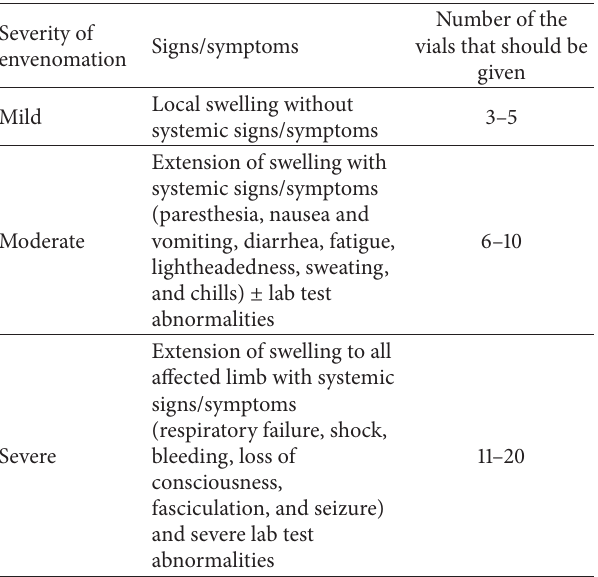
Table 1: Iranian-modified WHO diagram for management of snake